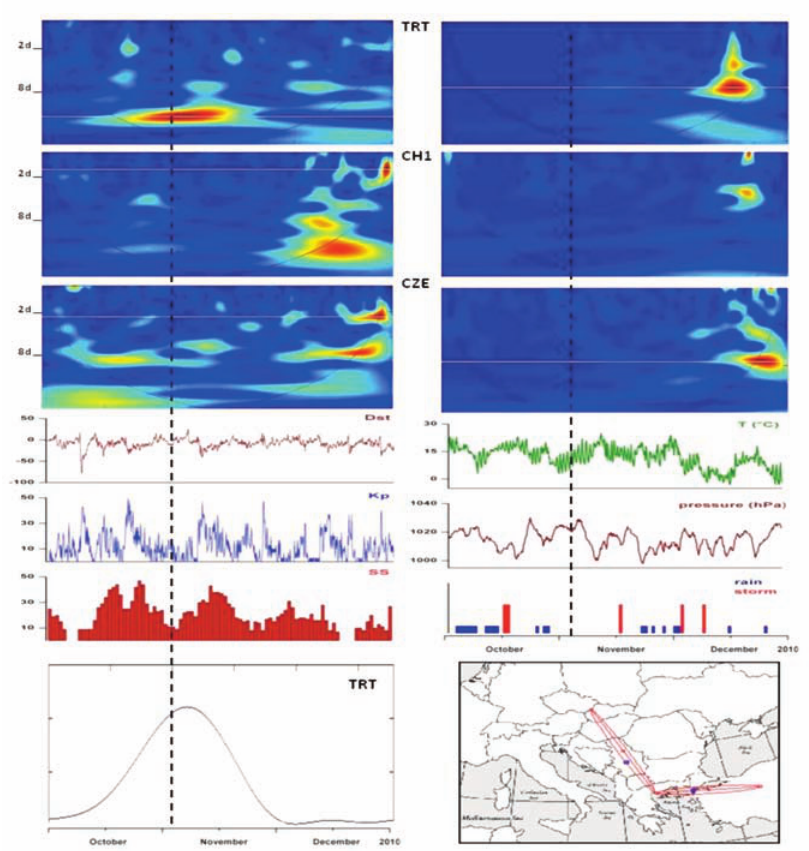
Figure 6. Night-time and day-time spectrograms of the TRT (180 kHz), CH1 (198 kHz) and CZE (270 kHz) transmitter radio signals collected by the GR receiver, together with the geomagnetic/solar and the (local) meteorological data, from October to December 2010. Top panels: Spectrograms of the night- time (left) and day-time (right) radio signals. Continuous black lines, delimitation of the region (COI) of the wavelet spectra in which edge effects become important [Torrence and Compo 1998]. Centre panels: Dst and Kp geomagnetic indices and solar burst numbers (SS) (left), and air temperature, air pressure and occurrence of rain and storms (right). Bottom panels: Wavelet power corresponding to the Fourier period in which the maximum power was found for the 180 kHz signal (left), and map showing the 5th Fresnel zone of the GR/TRT and GR/CZE paths (right), showing the epicentres of the November 3, 2010, earthquakes that occurred inside these zones. Vertical dashed lines, times of occurrence of these